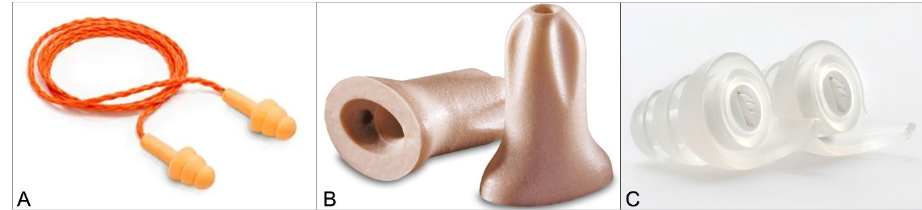
Figure 1. Hearing protection device models used in the study. Legend: ( A )—3M Pomp Plus ® hearing protection; ( B )—Acoustic Foam hearing protection, manufactured by Mack’s ® ; ( C )—Universal musician-specific high-fidelity hearing protection, manufactured by Mack’s ® . Source A: https://www.3m.com.br/3M/pt_BR/p/d/v000491409/ Access on 22 May 2022. Source B: https://www.macksearplugs.com/product/acoustic-foam-ear-plugs/ Access on 22 May 2022. Source C: https://www.macksearplugs.com/product/hear-plugs-high-fidelity-ear-plugs/ Access on 22 May 2022.